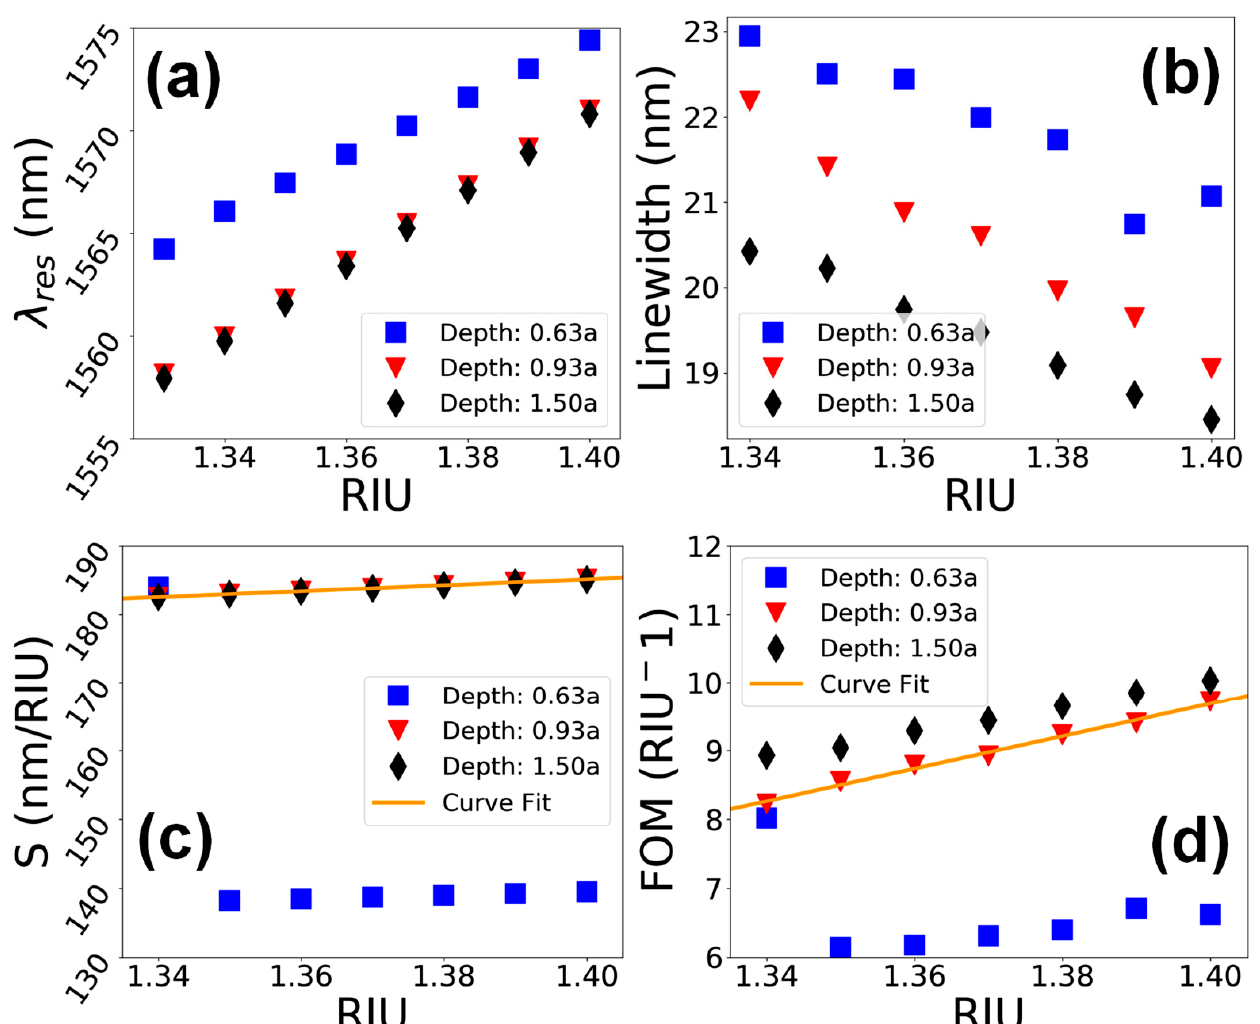
Figure 11. Performance evaluation of the device for hole depths of d = 0.63 a , 0.93 a and 1.5 a in cylindrical PhC elements. ( a ) λ res vs. RIU. ( b ) Linewidth vs. RIU. ( c ) S vs. RIU. ( d ) FOM vs. RIU.